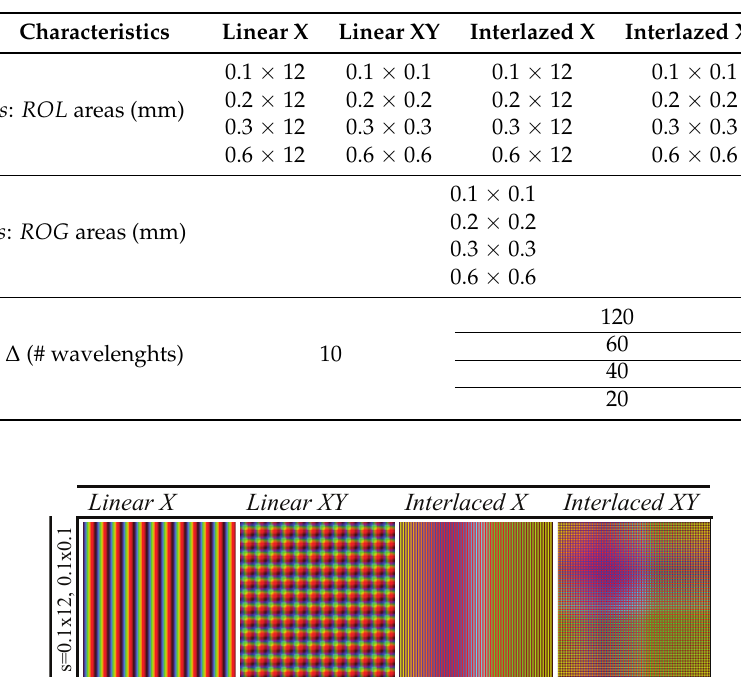
Table 3. Parameters for the transformations Υ Φ used in experiments.